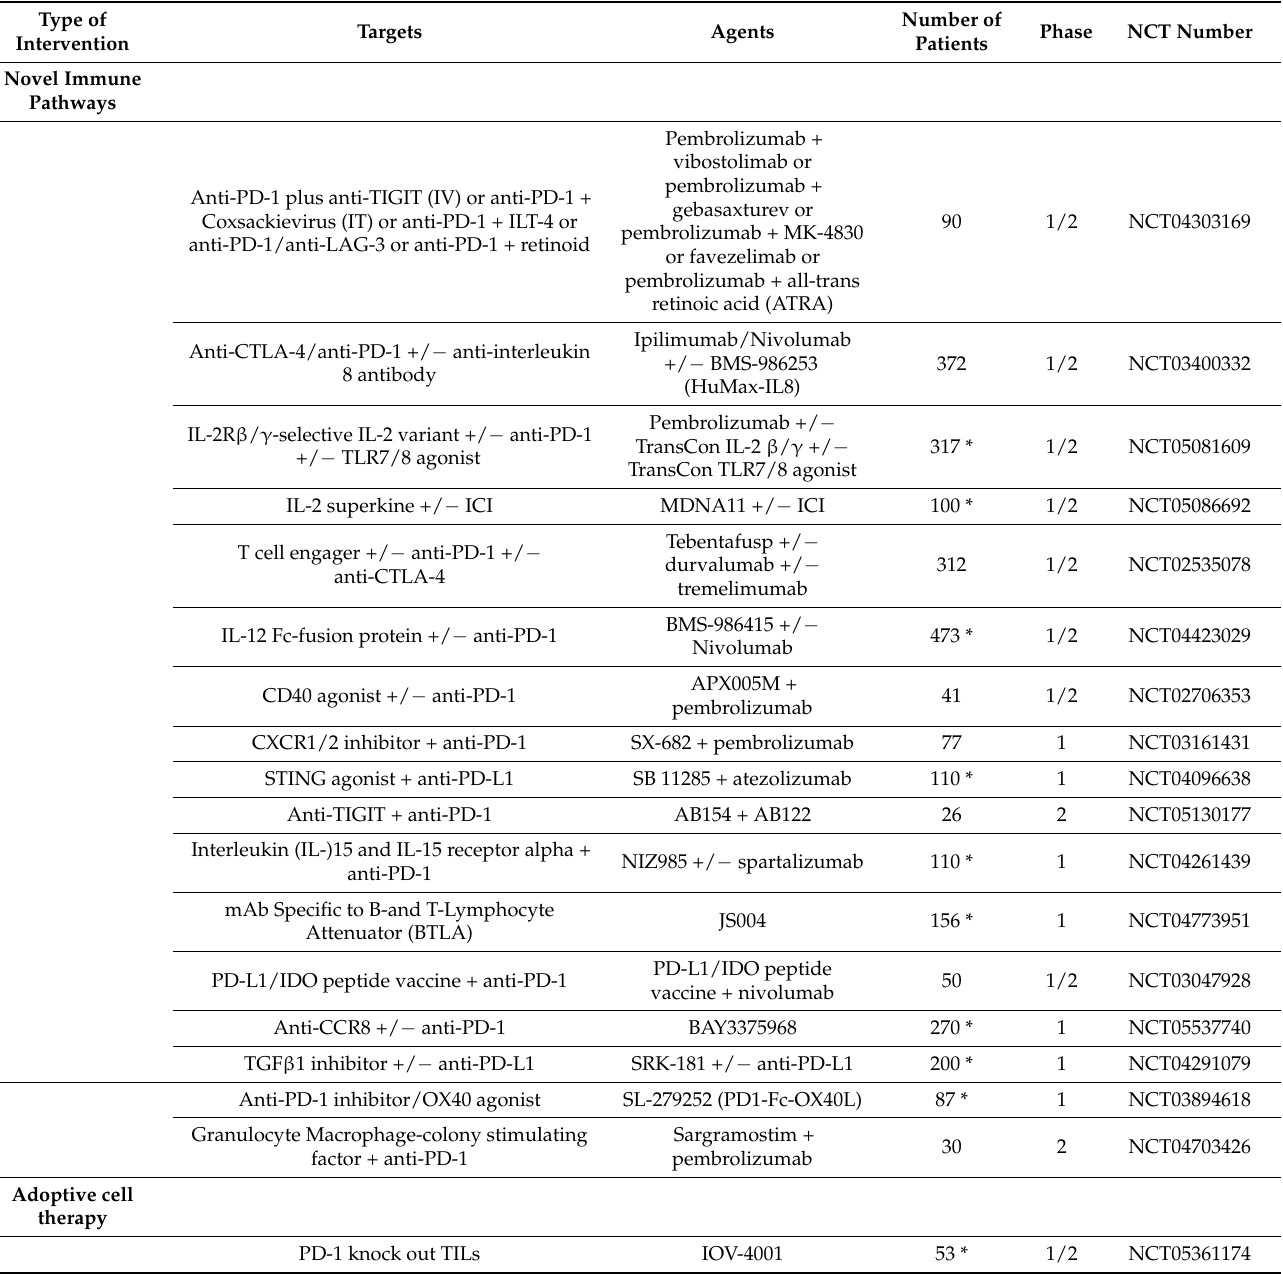
Table 1. Ongoing clinical trials with immunotherapy in advanced cutaneous melanoma (as as- sessed on 13 November 2022). * Denotes studies that also include patients with tumor types other than